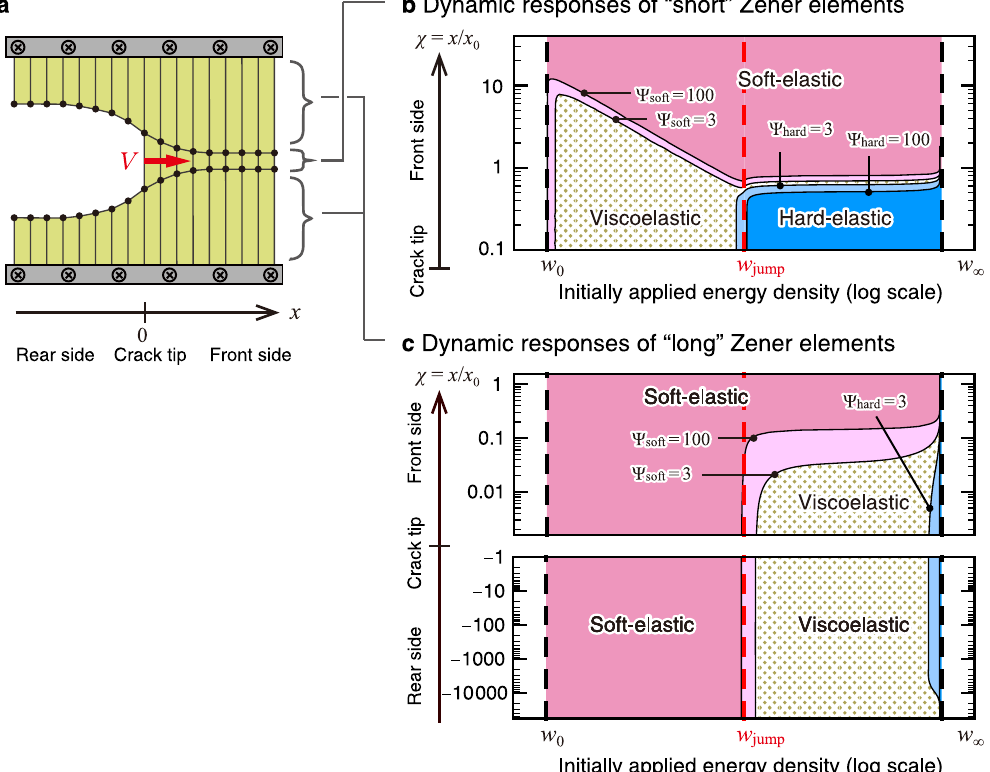
Figure 5. Dynamic responses of Zener elements. ( a ) “Short” and “long” Zener elements of natural length l and ( L − l )/2, respectively. Here, we set the origin of the x -coordinate at the crack tip. ( b , c ) Representative behavior of dynamic responses of Zener elements for conventional elastomers ( λ = 10 3 and N = 10 9 ). We show relaxational responses of Zener elements during a constant-velocity crack propagation, in contrast to vibrational responses in Fig. 3. The four curves are contours for Ψ soft = 100, 3 and Ψ hard = 3, 100 as a function of the initially applied energy density w and the distance from the crack tip χ ≡ x / x 0 . The conditions Ψ  1 correspond to soft- and hard-elastic regimes, respectively (see the text for details). Explicit forms of Ψ soft , Ψ hard , and x 0 are given in Methods. Red dashed lines correspond to the velocity jump ( w jump ) and black dashed lines correspond to the minimum ( w 0 ) and maximum ( w ∞ ) values of w for with constant-velocity